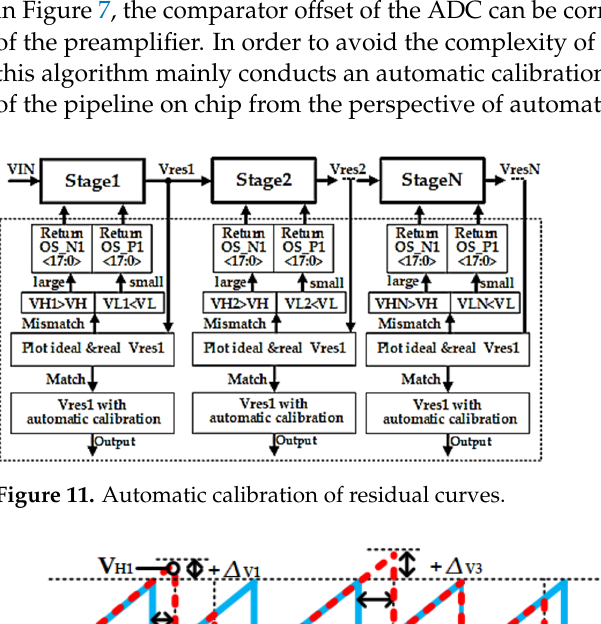
Figure 12. Algorithm for calibration of residual curves.